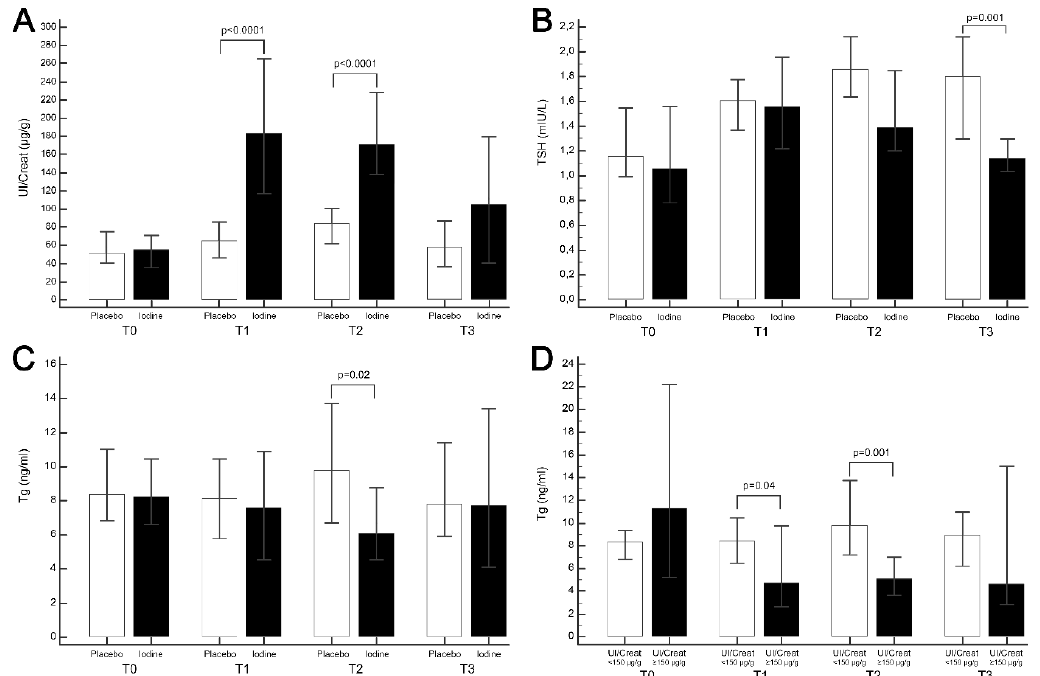
Figure 1. ( A ) Median urinary iodine-to-creatinine concentrations (UI/Creat, ug/g) in the Iodine